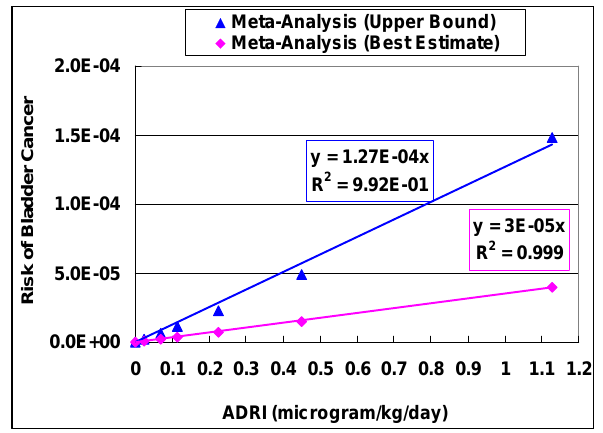
Figure 6: Slope factors of bladder cancer generated from meta-analysis